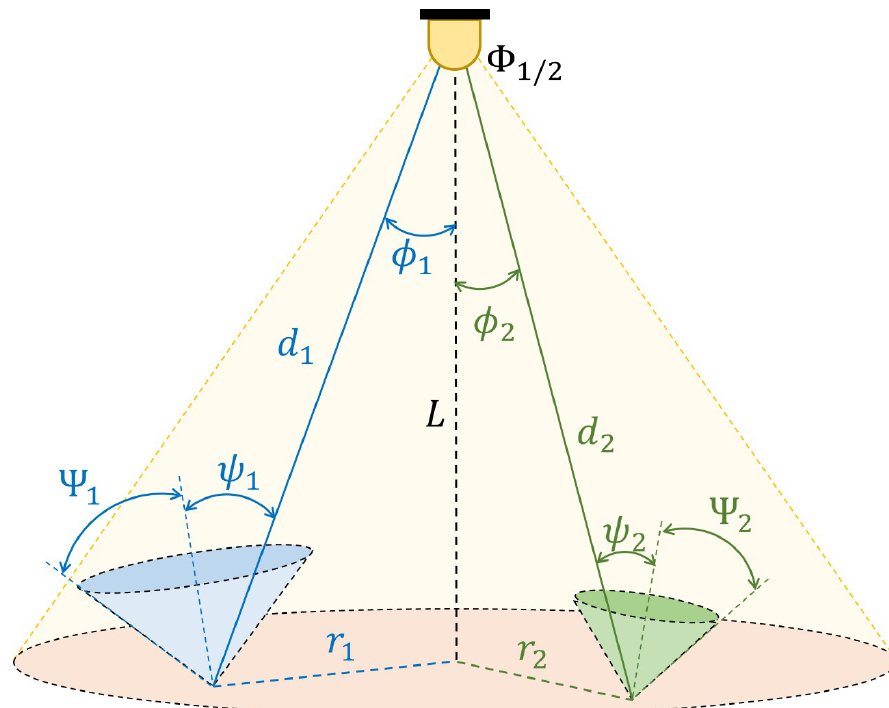
Figure 1. A VLC attocell with a single LED and two